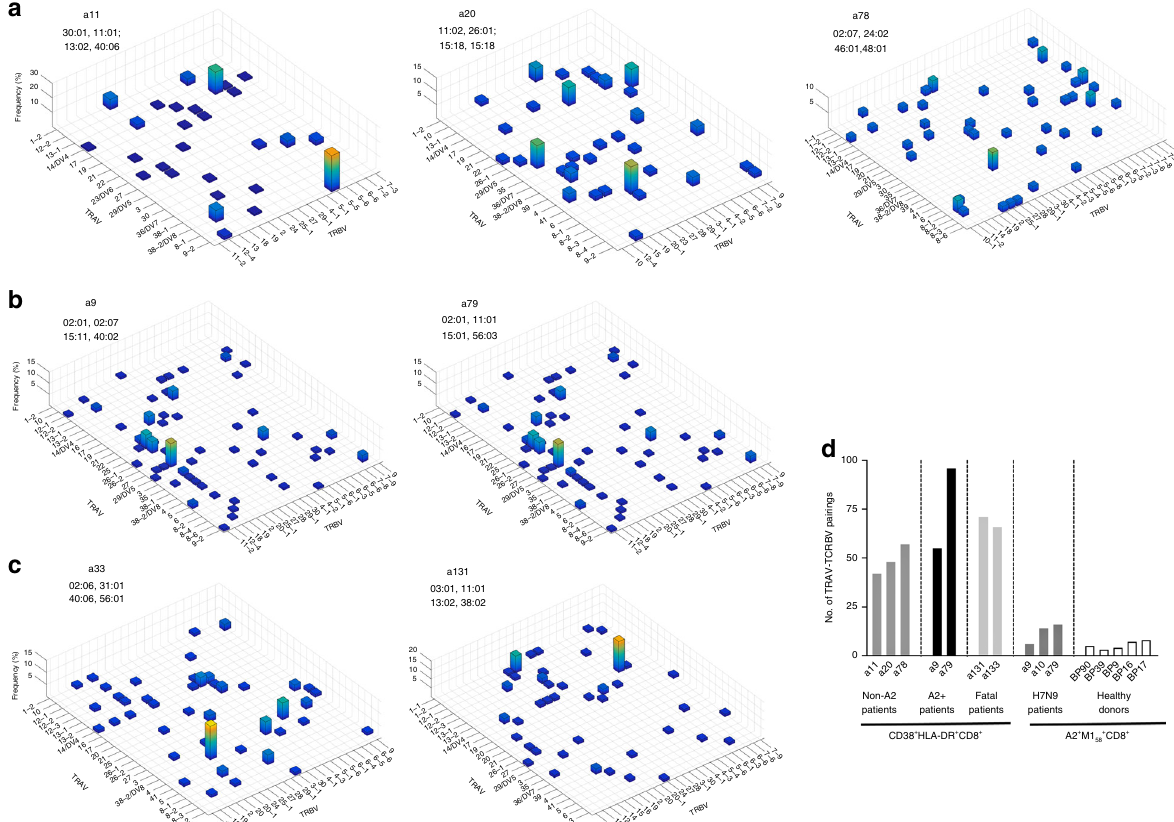
Fig. 4 Diverse usage of TCR α – TCR β pairings within CD38 + HLA-DR + CD8 + T cells. The frequency of TCR αβ clonotypes within particular TRAV – TRBV paired segments is shown for individual patients: a non-HLA-A*02:01 surviving individuals; b HLA-A*02:01 surviving individuals; c patients with a fatal disease outcome. Pulled data from all the time-points is shown, as summarized in Supplementary Table 5. d The number of speci fi c TRBV – TRAV paired segments utilized per donor is shown for non-HLA-A*02:01 surviving patients, HLA-A*02:01 surviving patients and fatal patients for CD38 + HLA-DR + CD8 + T cells as well for H7N9 surviving patient and healthy individuals for A2-M1 58 + CD8 + T